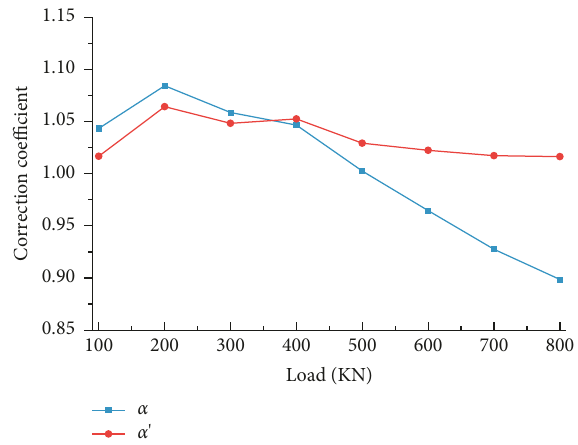
Figure 13: Comparison of stiffness correction coefficients calcu- lated by theoretical values and FEM values. α was the stiffness correction coefficients calculated by theoretical values, and α � ( W ) (0) /( W ) (1) . α ′ was the stiffness correction coefficients cal- culated by FEM values, and α ′ � ( W ) (2) /( W ) (1) . ( W ) (1) was the vertical displacement obtained by analyzing the measured data of the sensors. ( W ) (2) was the vertical displacement obtained by the finite element method. ( W ) (0) was the vertical displacement ob- tained by the theoretical formulas of composite beam with UDS in Section